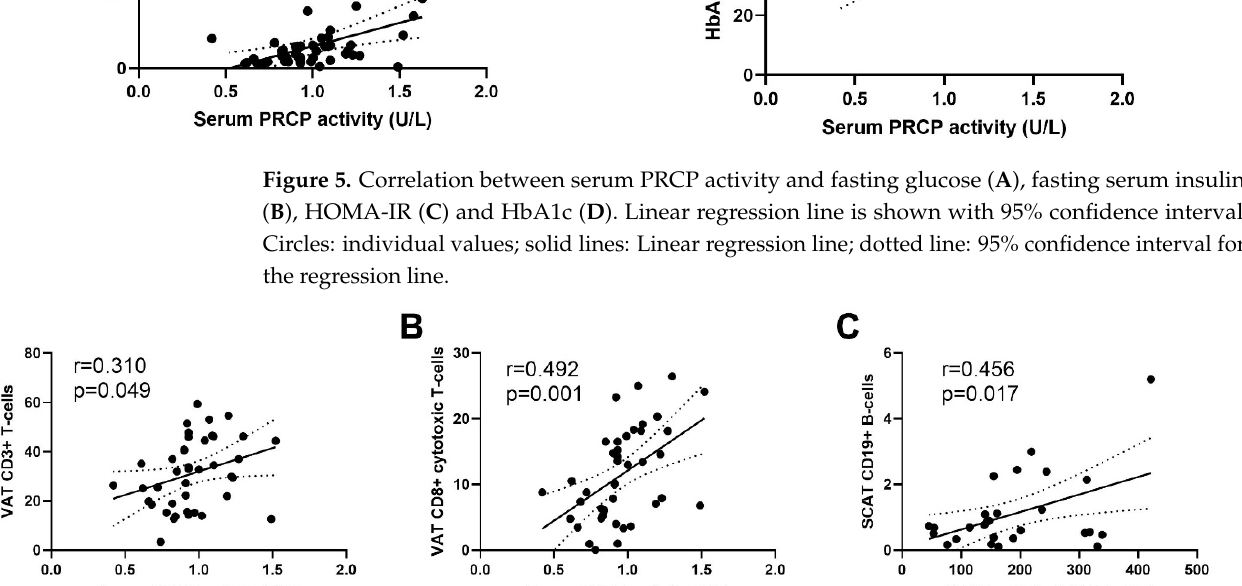
Figure 5. Correlation between serum PRCP activity and fasting glucose ( A ), fasting serum insulin ( B ), HOMA-IR ( C ) and HbA1c ( D ). Linear regression line is shown with 95% confidence interval. Circles: individual values; solid lines: Linear regression line; dotted line: 95% confidence interval for the regression line.